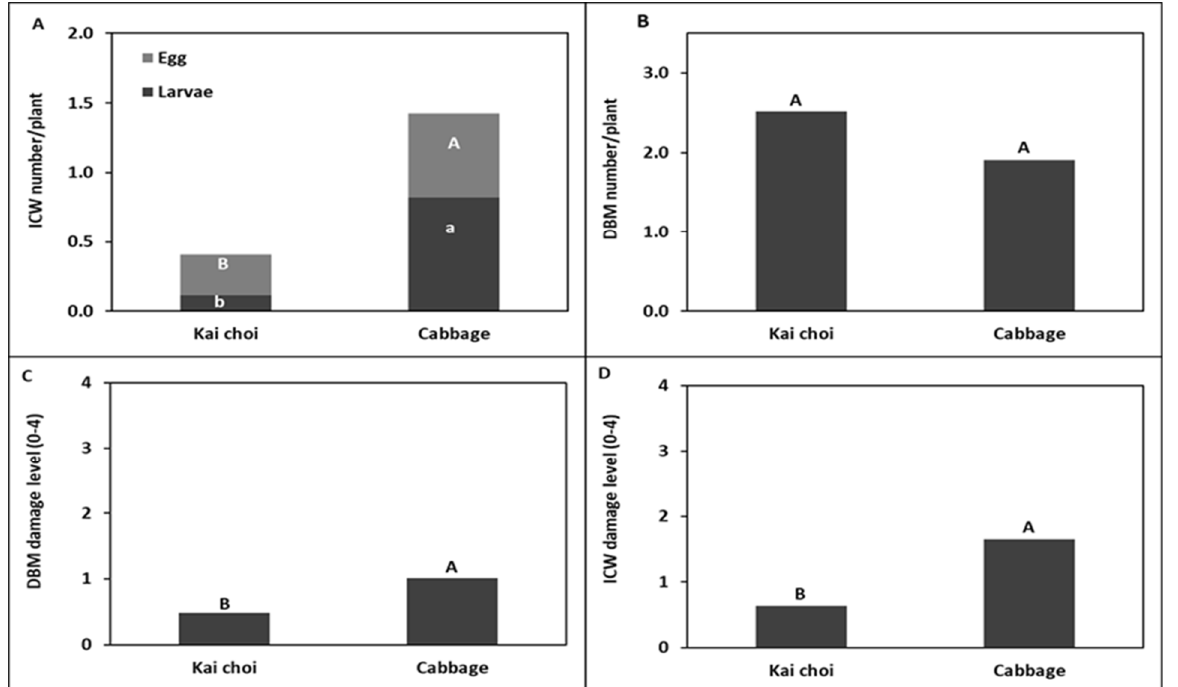
Figure 9. Abundance of ( A ) Imported cabbage worm (ICW) larvae and eggs; ( B ) Diamondback moth (DBM) larvae; ( C ) Percentage of ICW; ( D ) DBM leaf damage on kai choi and head cabbage in Trial II (Kauai Trial). Columns (n = 96) followed by the same letter in a graph are not different based on analysis of